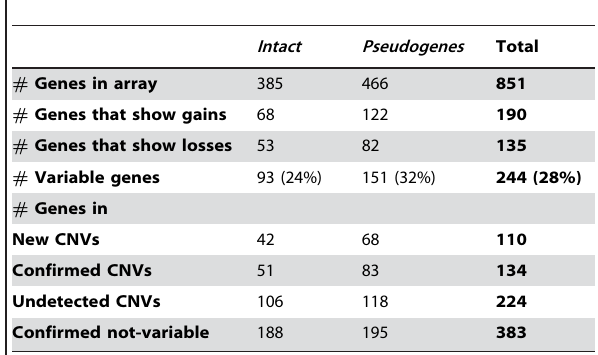
Table 1. Summary of array results for OR gene and pseudogene loci and comparison with DGV.